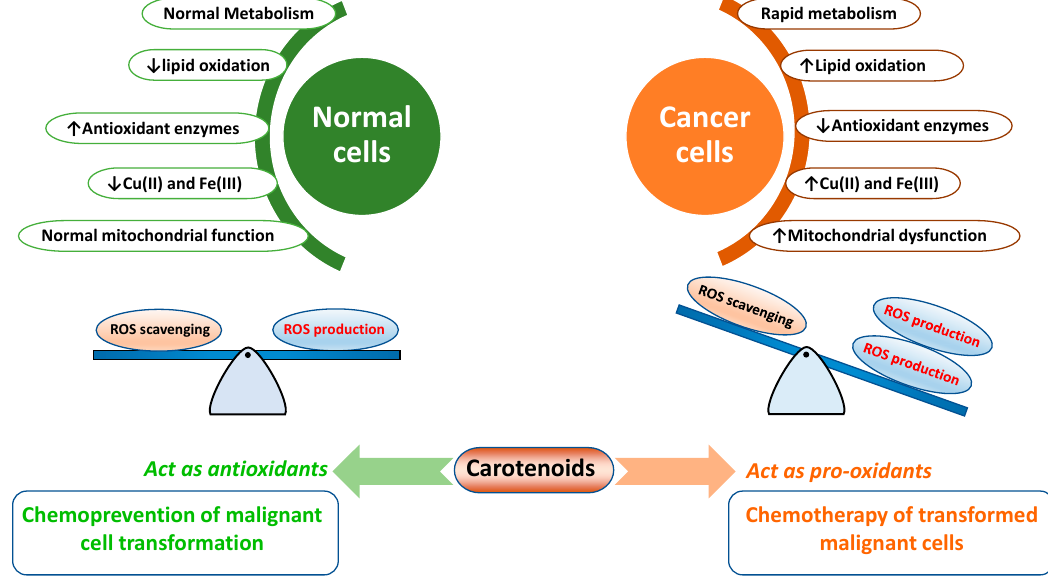
Figure 1. An outline of major differences in cellular metabolism between normal and cancer cells. Under pre-existence conditions of high oxidative stress in cancer cells, carotenoids predominantly function as pro-oxidants, resulting in the ROS-triggered apoptosis of cancer cells. Carotenoids are yellow, orange, and red tetraterpenoid pigments universally synthesized by all terrestrial and aquatic photoautotrophs, including plants, algae, some non-photosynthetic bacteria, some insects, and some fungi [6]. Since animals (excluding some species gall midges, pea aphids, and spider mites) are incapable of biosynthesizing carotenoids [7], they need to obtain carotenoid from